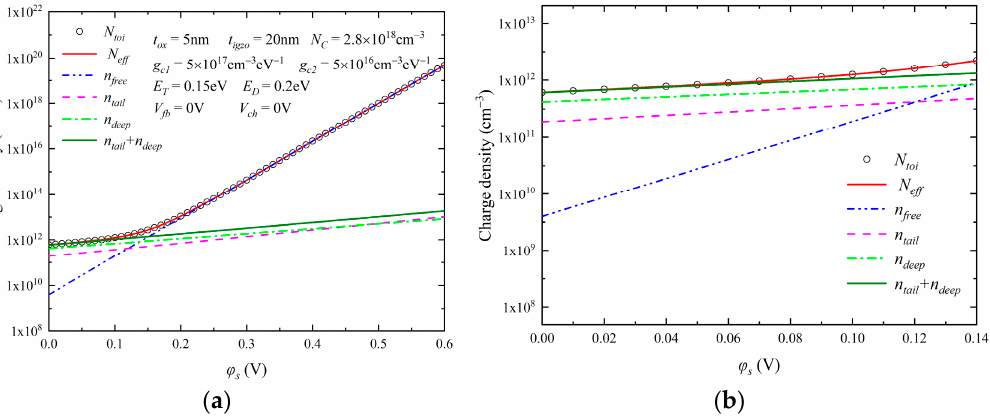
Figure 2. ( a ) Different charge densities versus surface potential curves with E T = 0.15 eV , E D = 0.2 eV and ( b ) partial enlarged view from 0 V–0.14 V.